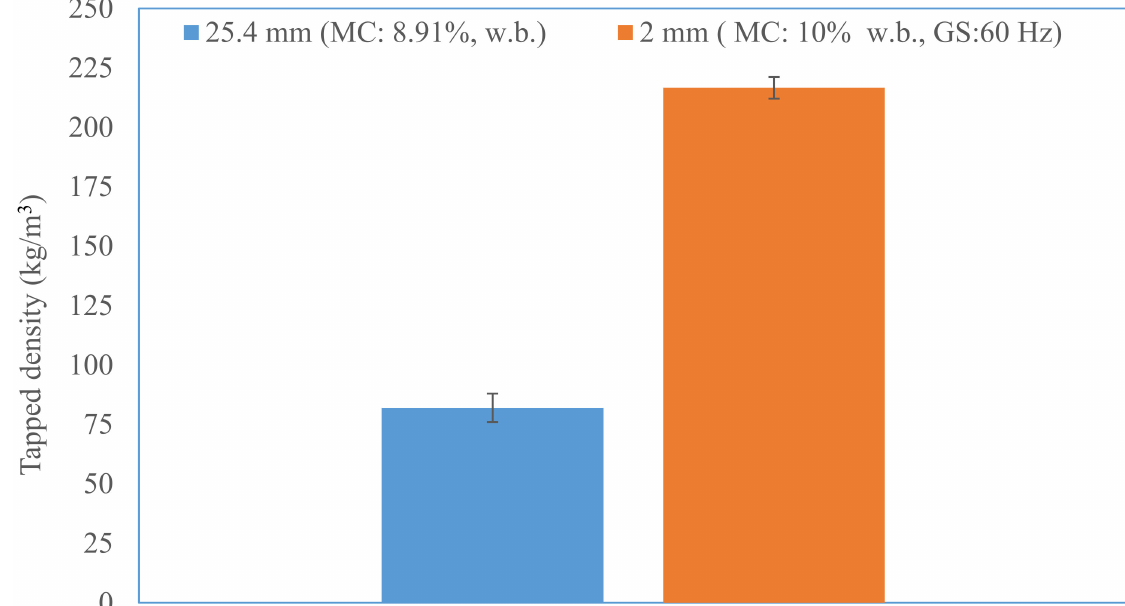
Figure 8. The comparison of the tapped density of the 25.4 mm and 2 mm screen size grind. (Note: GM: grinder speed and MC: corn stover moisture content).